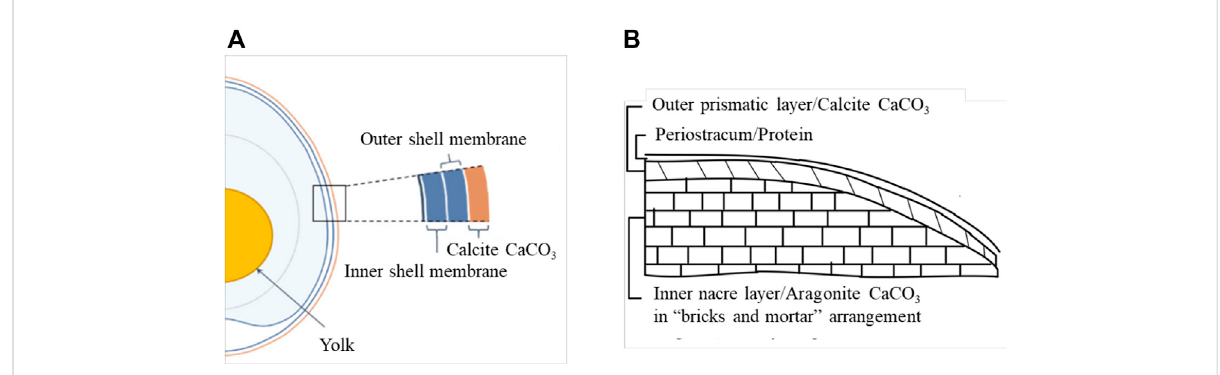
FIGURE 1 Schematics microstructures illustration of (A) Eggshell. Reproduced from Shi et al. (2021) “ Avian eggshell membrane as a novel biomaterial A review ” https://www.mdpi.com/2304-8158/10/9/2178 licensed under CC BY 4.0. (B) mussel shell. Reproduced with permission from Matthews and Asadov (2020).